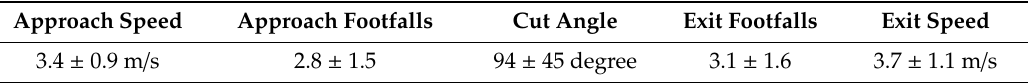
Table 2. Mean values of basic cut metrics for all detected cuts.